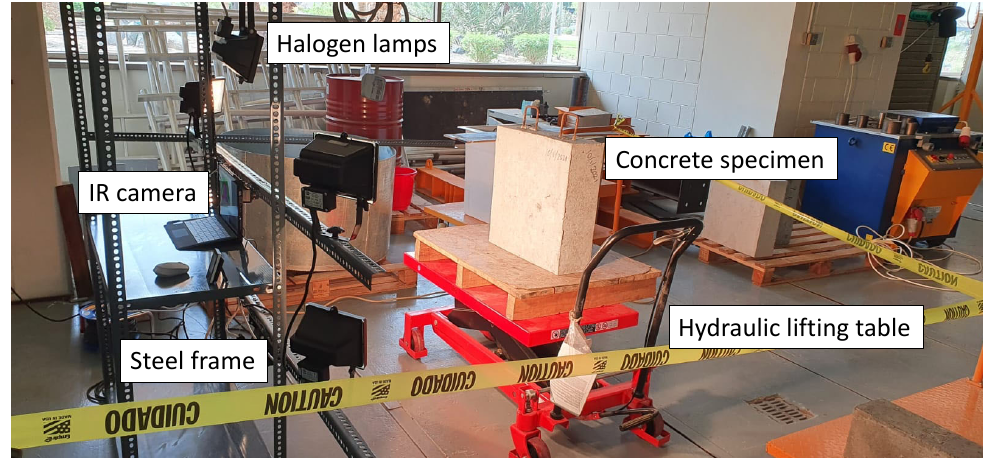
Figure 6. Experimental setup of the thermographic test in the process of heating the concrete speci- men.